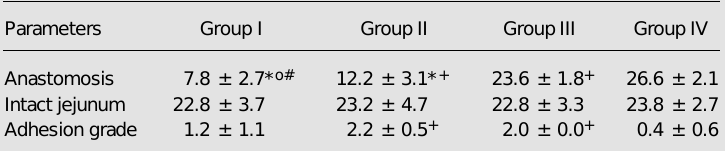
Table 1 - Resistance of jejunal anastomosis and intact jejunum and grade of adhesions in the presence of sodium carboxymethylcellulose (SCMC) and methylprednisolone in